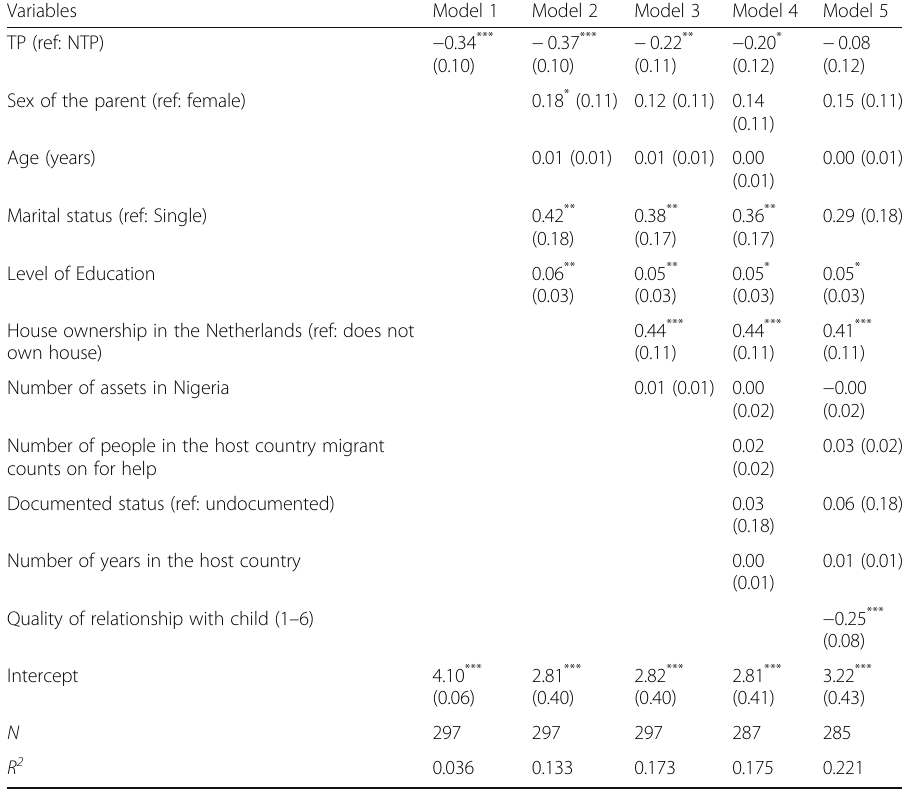
Table 6 Ordinary Least Squares regressions predicting satisfaction with life, The Netherlands Variables Model 1 Model 2 Model 3 Model 4 Model